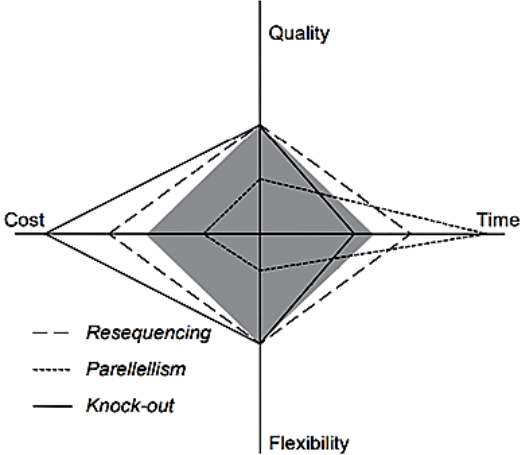
Figure 3. Devil’s quadrangle for the selected BP behavior heuristics.